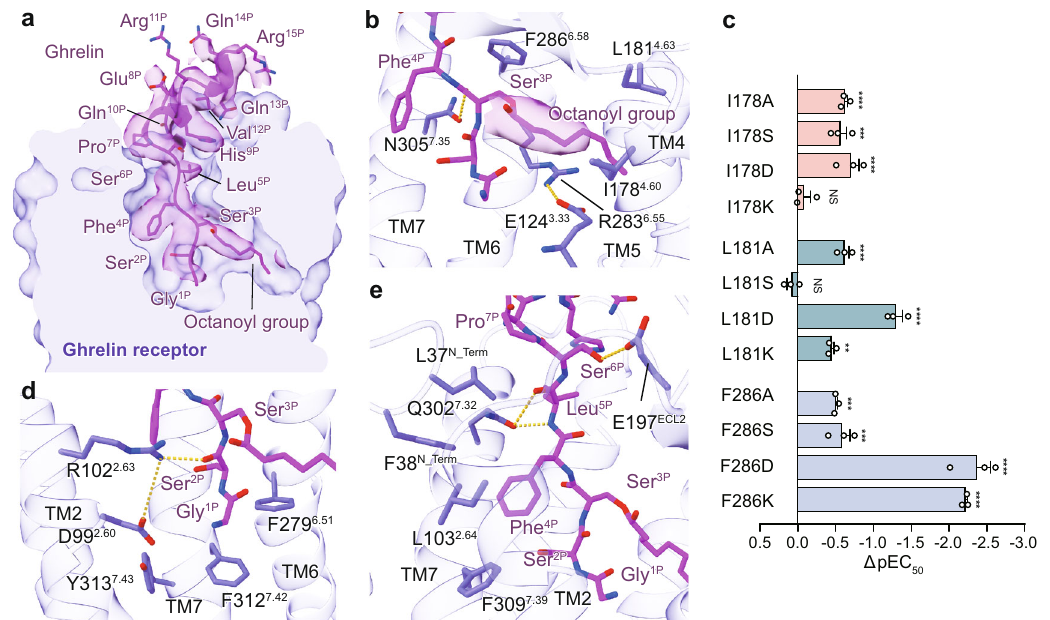
Fig. 2 The ghrelin-binding pocket of ghrelin receptor. a Cross-section of the ghrelin-binding pocket in ghrelin receptor. The cryo-EM density of ghrelin is highlighted. Ghrelin is shown in cartoon presentation. Side chains of the residues are displayed as sticks. b The binding pocket for octanoyl group. The cryo- EM density of the octanoyl group is shown. The hydrogen bonds are depicted as yellow dashed lines. c Effects of mutations of residues in the octanoyl group-binding pocket on calcium response. Δ pEC50 represents the difference between pEC 50 values of the mutant ghrelin receptor and the wild-type (WT) receptor. Data are presented as mean ± S.E.M. of three independent experiments performed in technical triplicate. *** P < 0.001, **** P < 0.0001 vs. WT receptor, NS, no signi fi cant difference. All data were analyzed by two-side, one-way ANOVA with Tukey ’ s test ( P < 0.0001, P = 0.0002, P < 0.0001, P = 0.9871, P < 0.0001, P = 0.9888, P < 0.0001, P = 0.0028, P = 0.0006, P = 0.0001, P < 0.0001, and P < 0.0001 from top to bottom). d , e